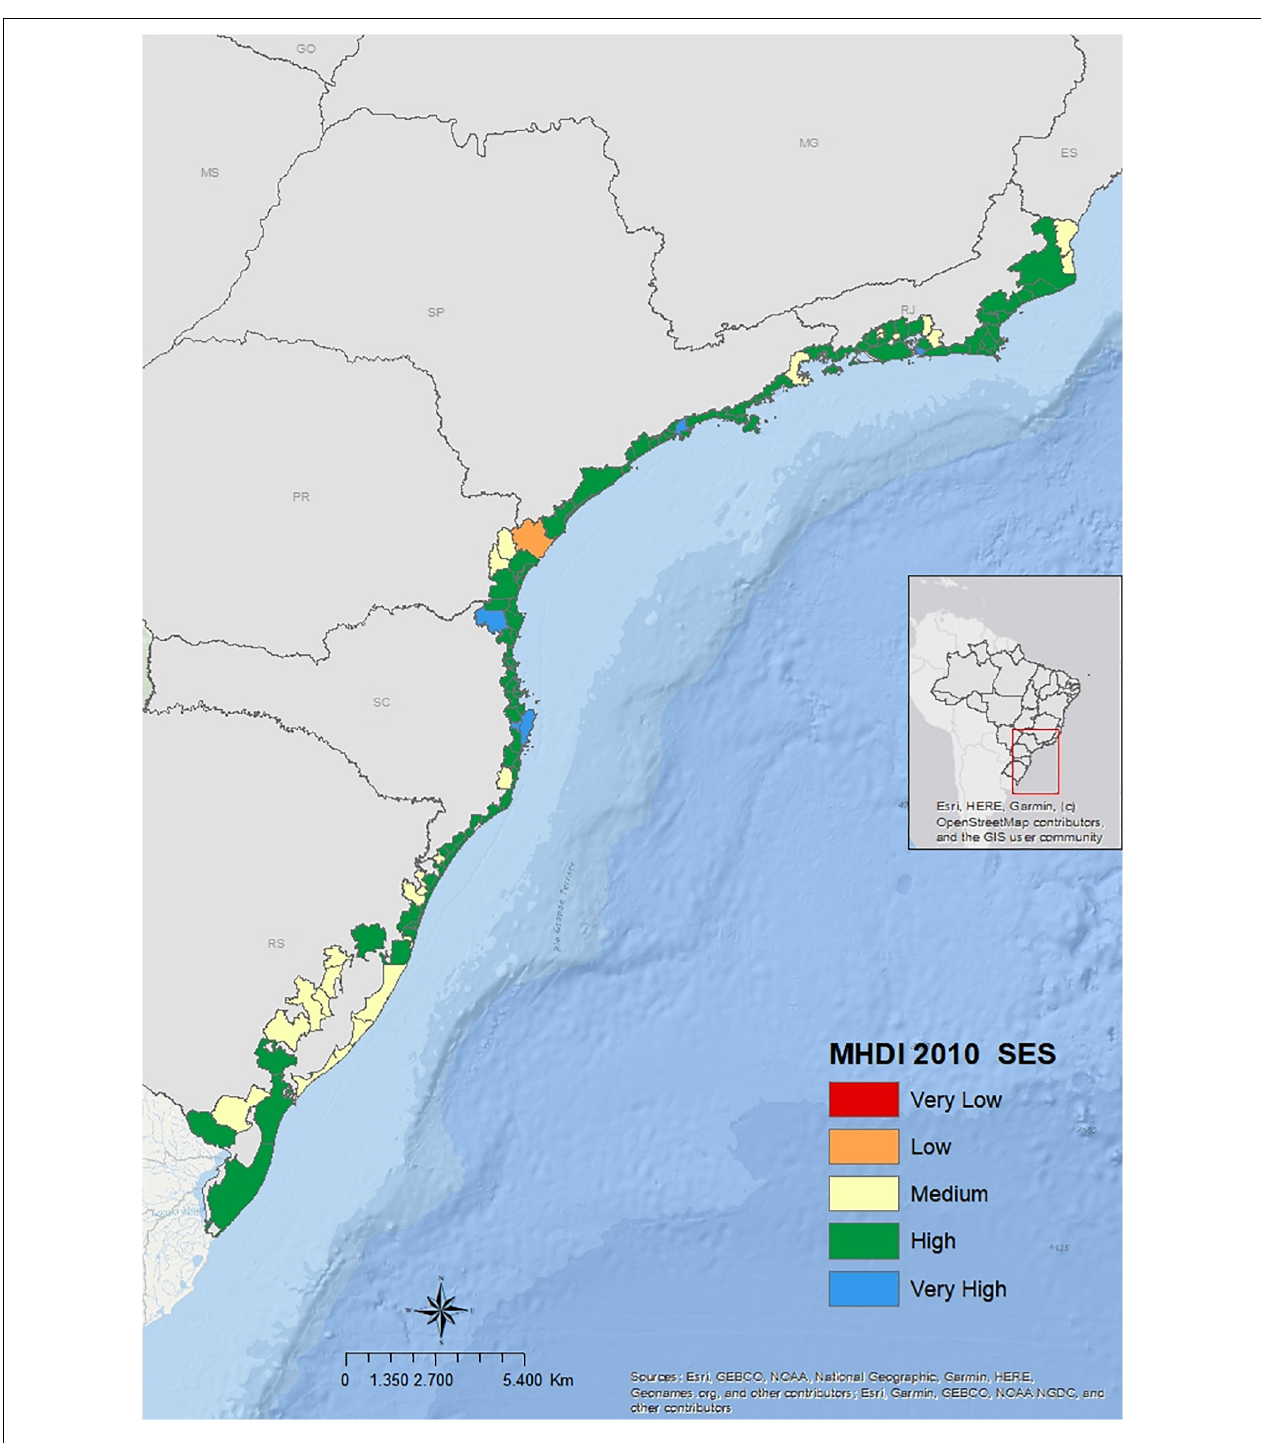
FIGURE 4 | MDHI for the South coast municipalities. Elaborated by the authors with data from PNUD et al.